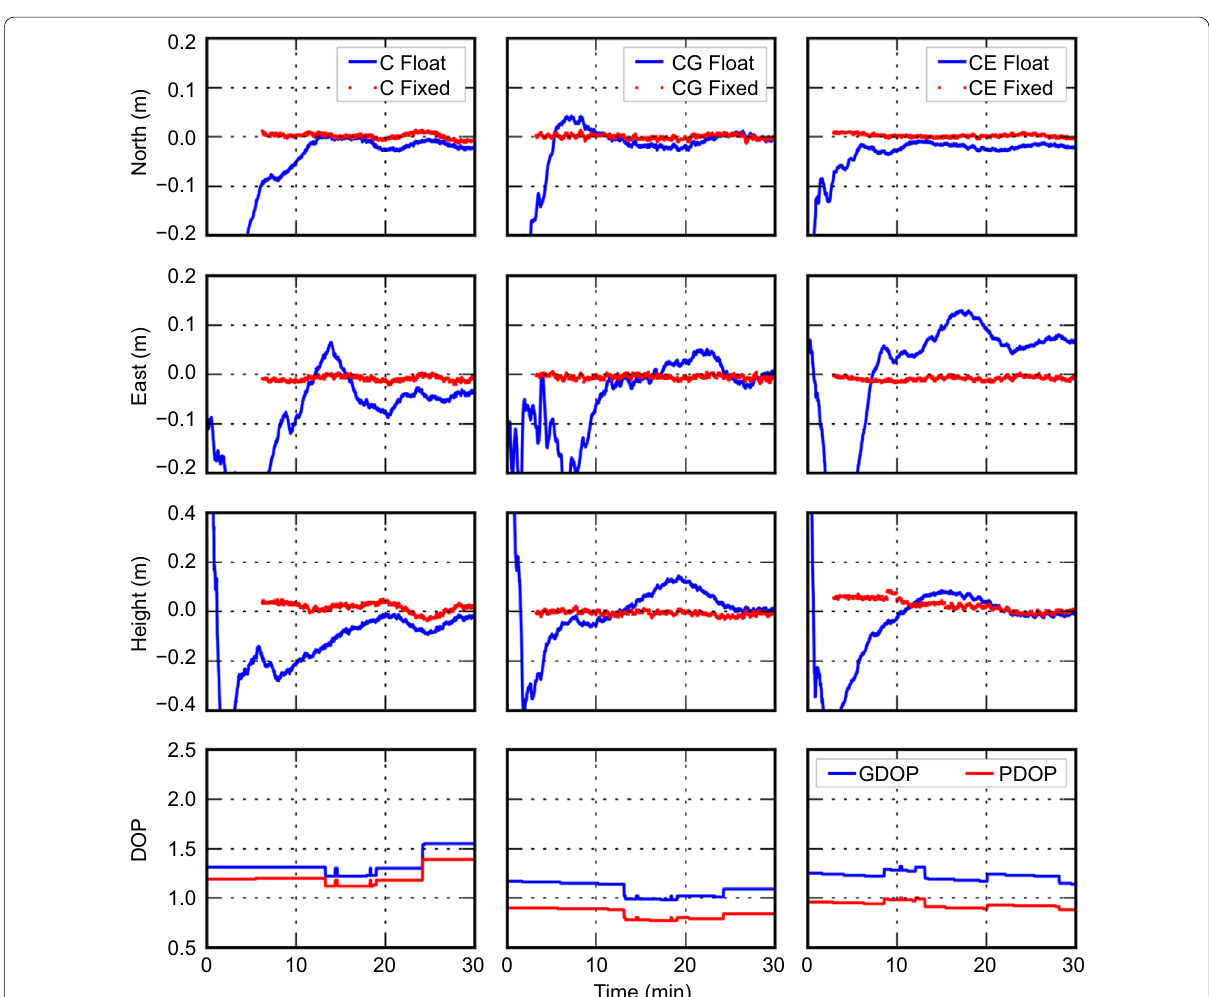
Fig. 11 30 min’s zooming in time series of PPP (blue line) and PPP-IAR (red dot) solutions of North (top row), East (the second row) and Height (middle row) components using BeiDou only (left), BeiDou/GPS (middle) and BeiDou/Galileo (right) measurements. The PDOP and GDOP series (bottom line) are displayed as